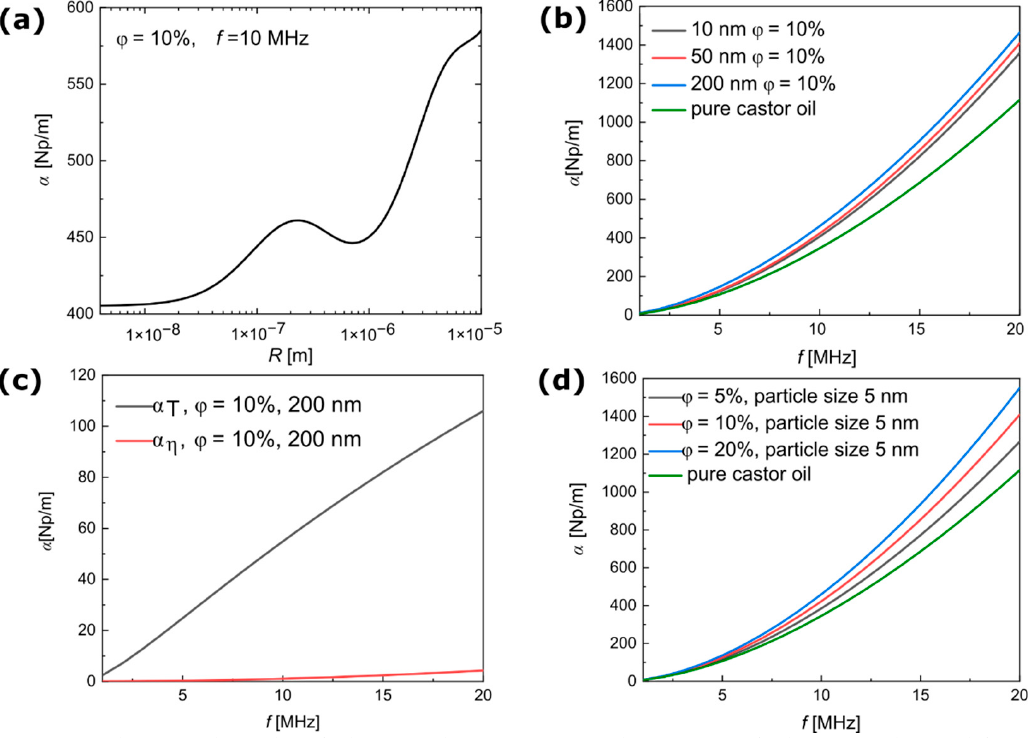
Figure 2. Theoretical results of ultrasound attenuation in dispersions of silica NPs obtained from the ECAH model. ( a ) Ultrasound attenuation coefficient versus particle radius at a constant frequency of 10 MHz. ( b ) Ultrasound attenuation coefficient versus frequency in different particle sizes. ( c ) Contribution of thermal and viscous loss to the ultrasound attenuation coefficient without the influence of background attenuation. ( d ) Ultrasound attenuation coefficient versus frequency in different concentrations of silica NPs. The attenuation spectra of pure castor oil were obtained from [32] .